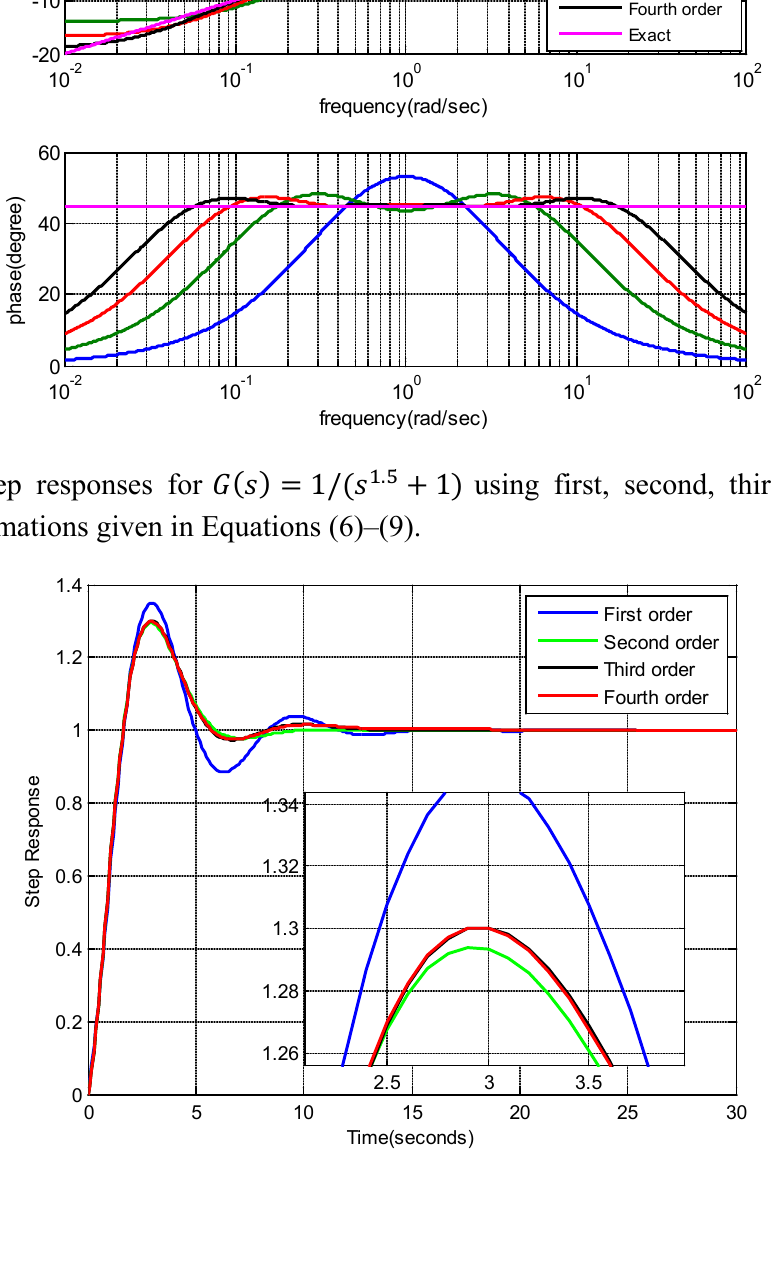
and first, second, third, fourth order approximations. 0.5 𝑠